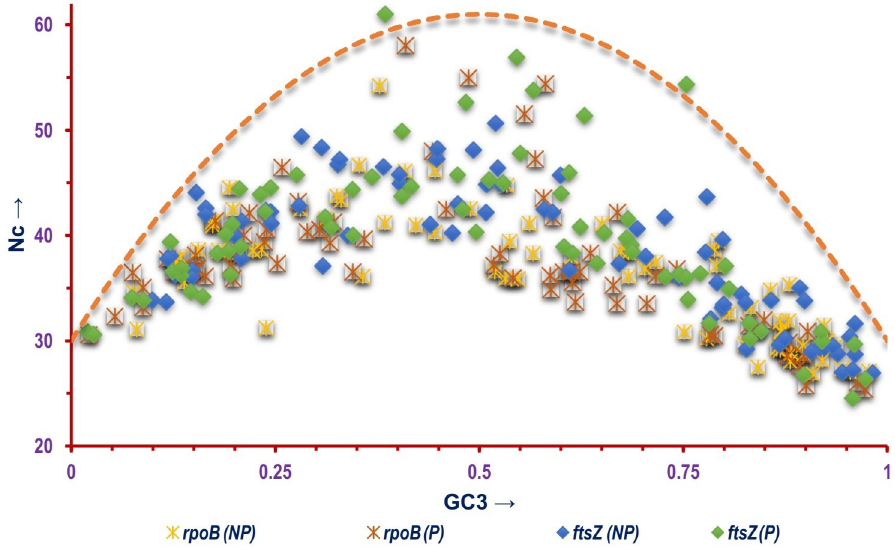
Fig 3. A composite Nc-plot depicting the correlation between Nc and GC3 of the ftsZ and rpoB CDS selected for this study based on lifestyle of the bacterial species where NP = CDS of non-pathogenic and P = CDS of pathogenic bacterial species. The orange dashed curve represents the null hypothesis that the GC bias at the synonymous site is solely due to mutation but not selection.